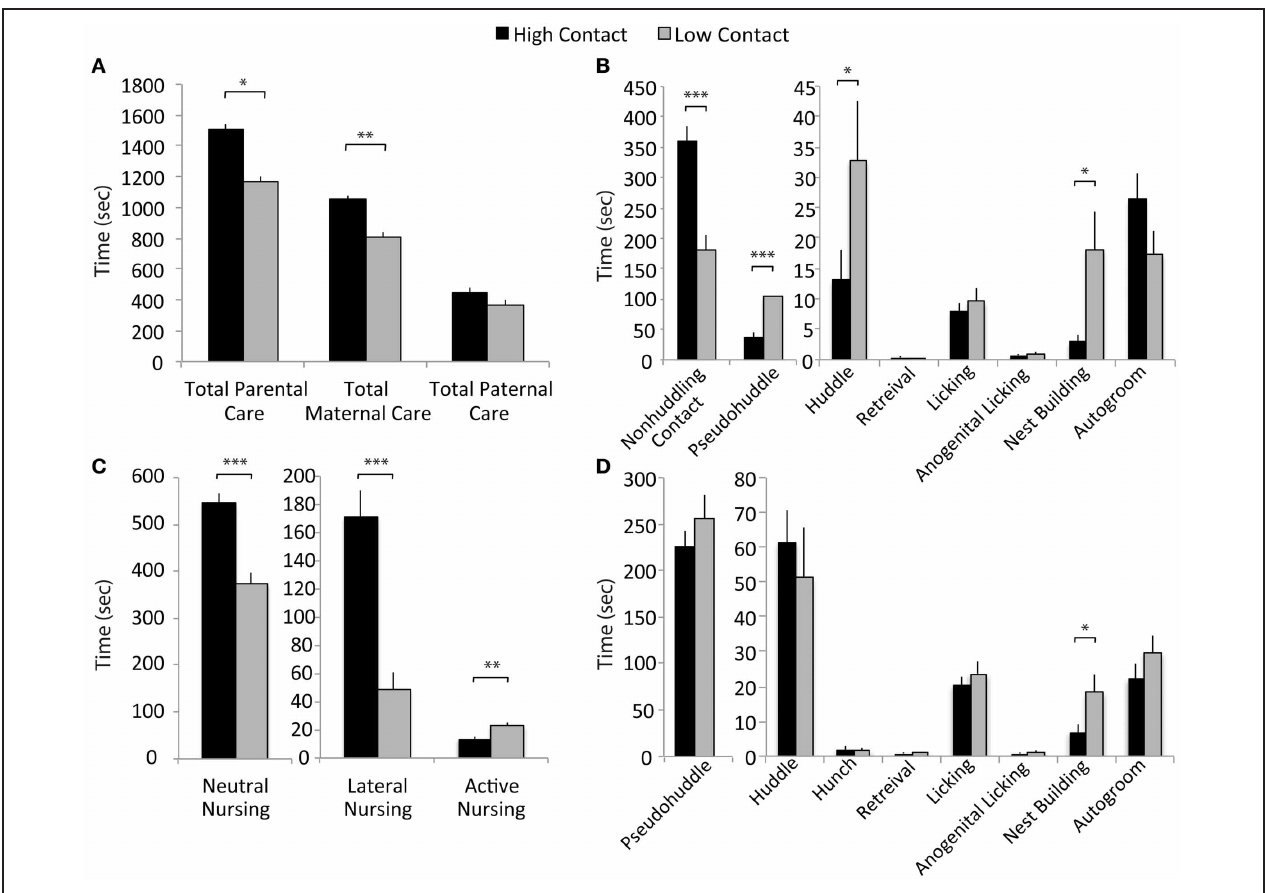
[ F ( 1 , 228 ) = 30 . 24, adjusted p = 0 . 0004]. Low-contact fathers also spent more time nest building [ F ( 1 , 228 ) = 6 . 71, adjusted p = 0 . 02]. (C) Mothers